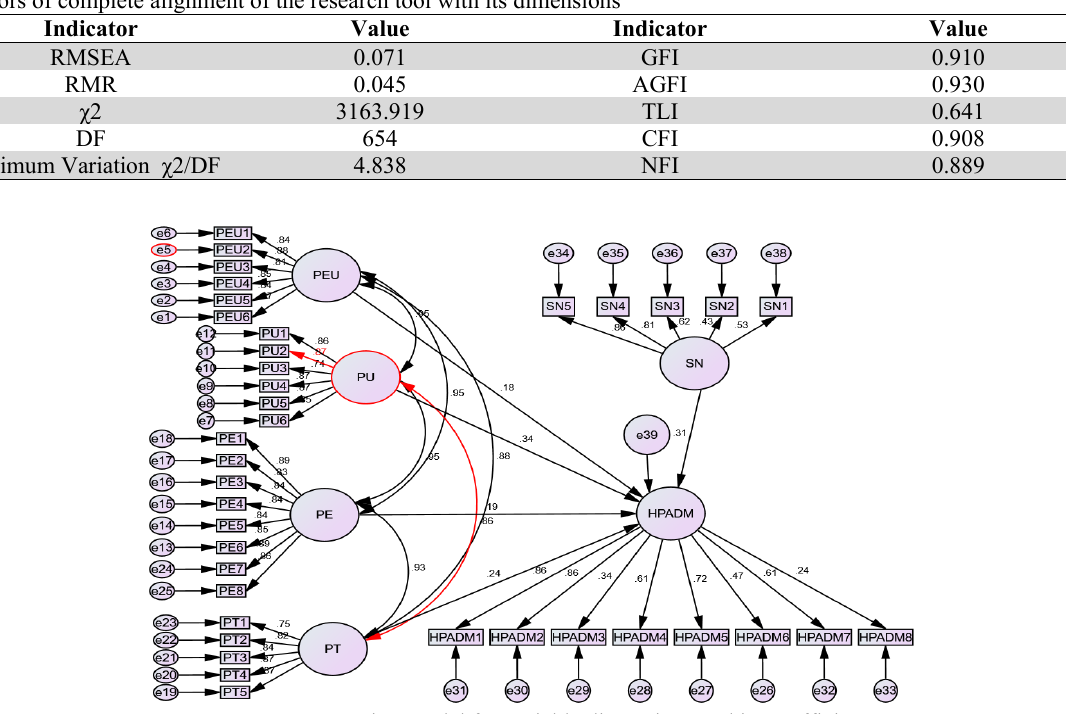
Fig. 2. Regression model for variable dimensions and its